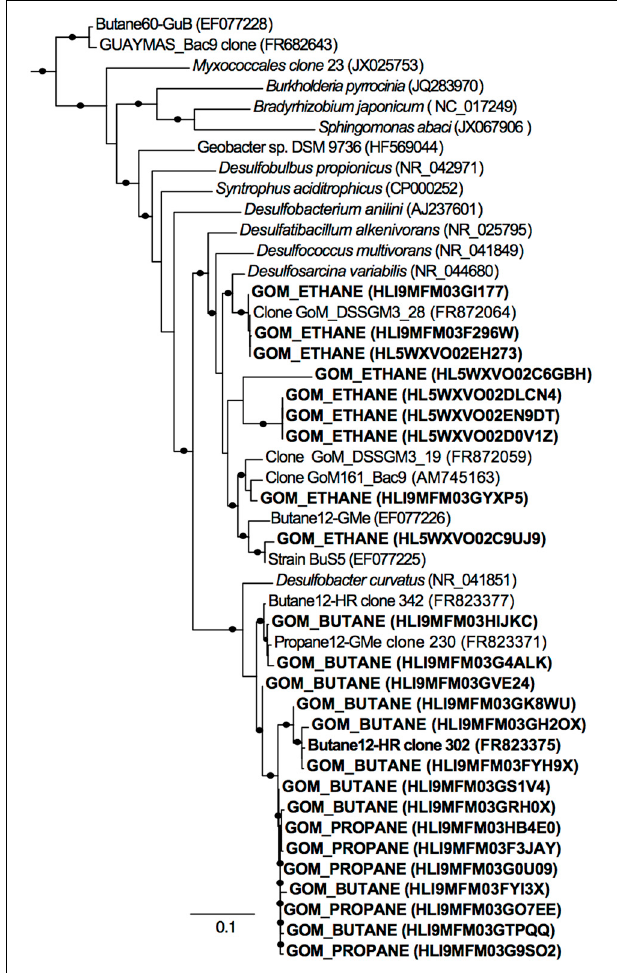
FIGURE 4 | Phylogenetic affiliation of 16S rRNA Deltaproteobacterial gene sequences retrieved from Gulf of Mexico batch reactor sediments. A total of 25 representative sequences from Gulf of Mexico sediments incubated in batch reactors with ethane (GOM_ETHANE), propane (GOM_PROPANE), and butane (GOM_BUTANE) are shown in bold. The phylogenetic tree was generated by maximum likelihood with FastTree Version 2.1.3. Local support values shown are based on the Shimodaira–Hasegawa (SH) test with 1000 resamples. Only values > 80% are shown on the branches as black circles. The 16S rRNA sequence of Archaeoglobus profundus DSM 5631(NR_074522) was used as an outgroup. Scale = 0.1 substitutions per